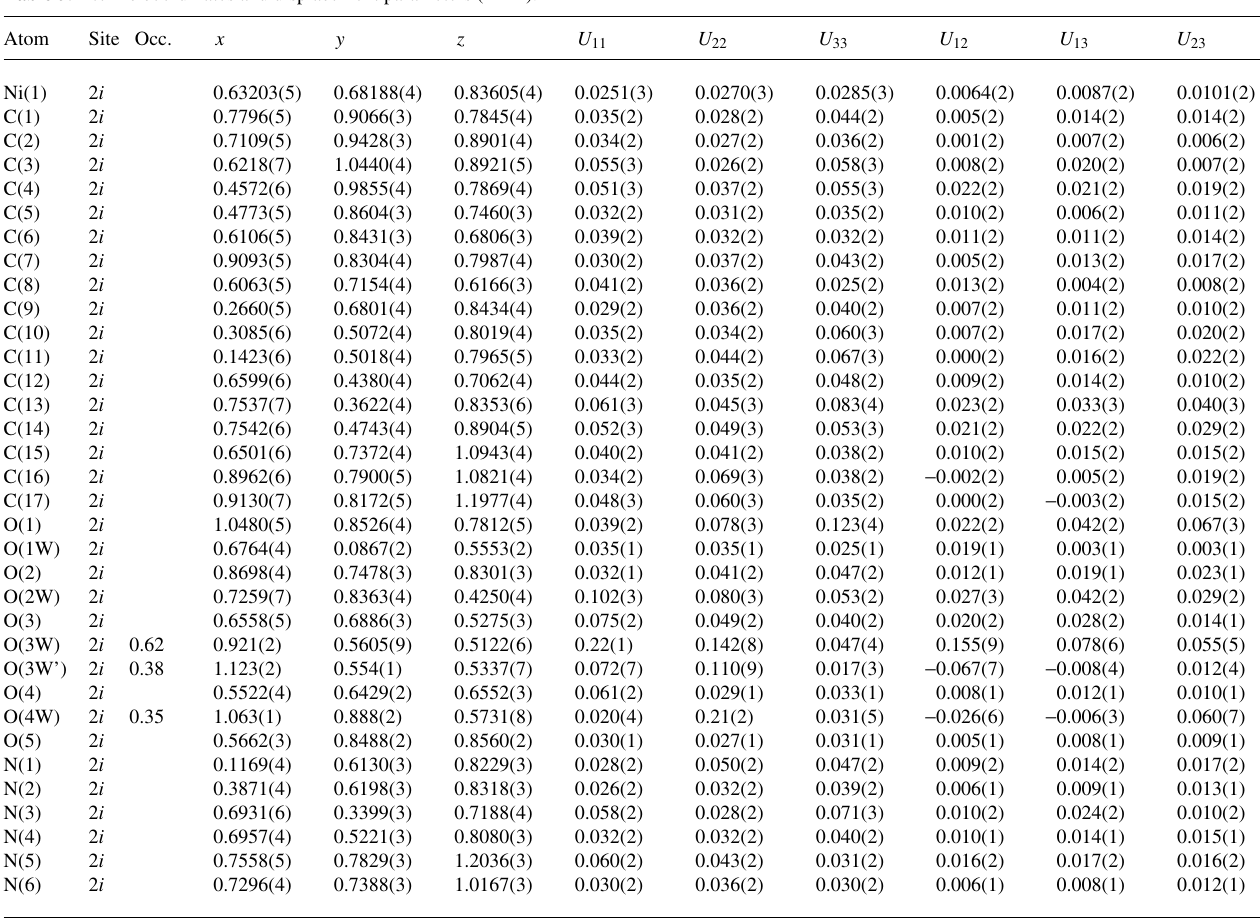
Table 3. Atomic coordinates and displacement parameters (in Å 2 )